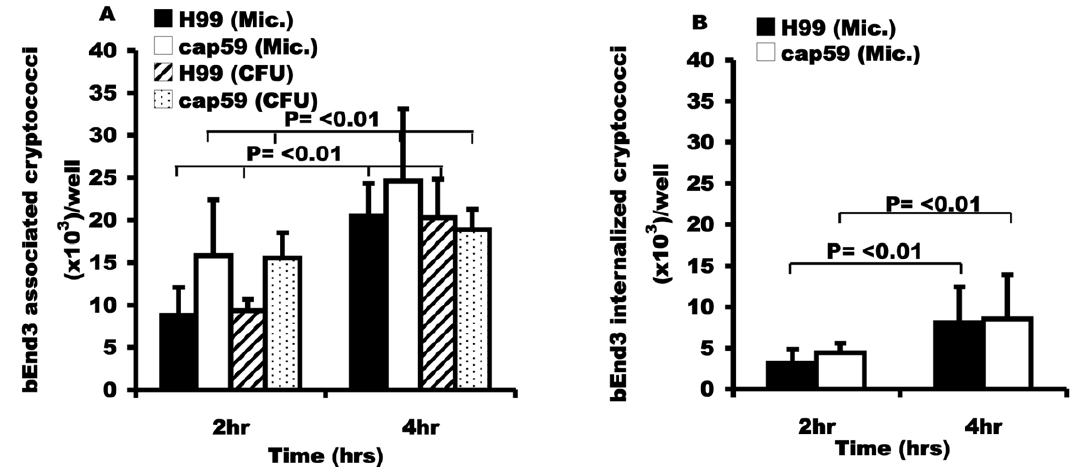
Figure 1. Binding and uptake of H99 and cap59 to the murine brain endothelial cell line, bEnd3. BEnd3 cells were exposed to wild type H99 and its acapsular derivative cap59 for 2 hr and 4 hr at 37 u C. (A) The rate of association (bound and internalized cryptococci) was determined both by microscopy and live CFU counts. The rate of association increased significantly in a time dependent manner, (P , 0.01 for both strains). However, there was no difference in association of encapsulated H99 or acapsular cap59 cells (P=0.1 and 0.5 at 2 hr and 4 hr respectively). (B) Internalization of the two strains, H99 and cap59 by bEnd3 cells as determined by fluorescence microscopy. Internalized cryptococci (pre-stained with FITC) were distinguished from extracellular adherent ones by counter labelling with calcofluor white after infection. Intracellular cryptococci retained the FITC green signal while extracellular cells acquired the blue signal from calcofluor. The number of phagocytosed cryptococci increased significantly in a time dependent manner, (P , 0.01 for both strains). However, there was no difference in internalization of encapsulated H99 and acapsular cap59, (P=0.5 and 0.8 at 2 hr and 4 hr respectively). Error bars are standard error of the mean, n=5 repeats.